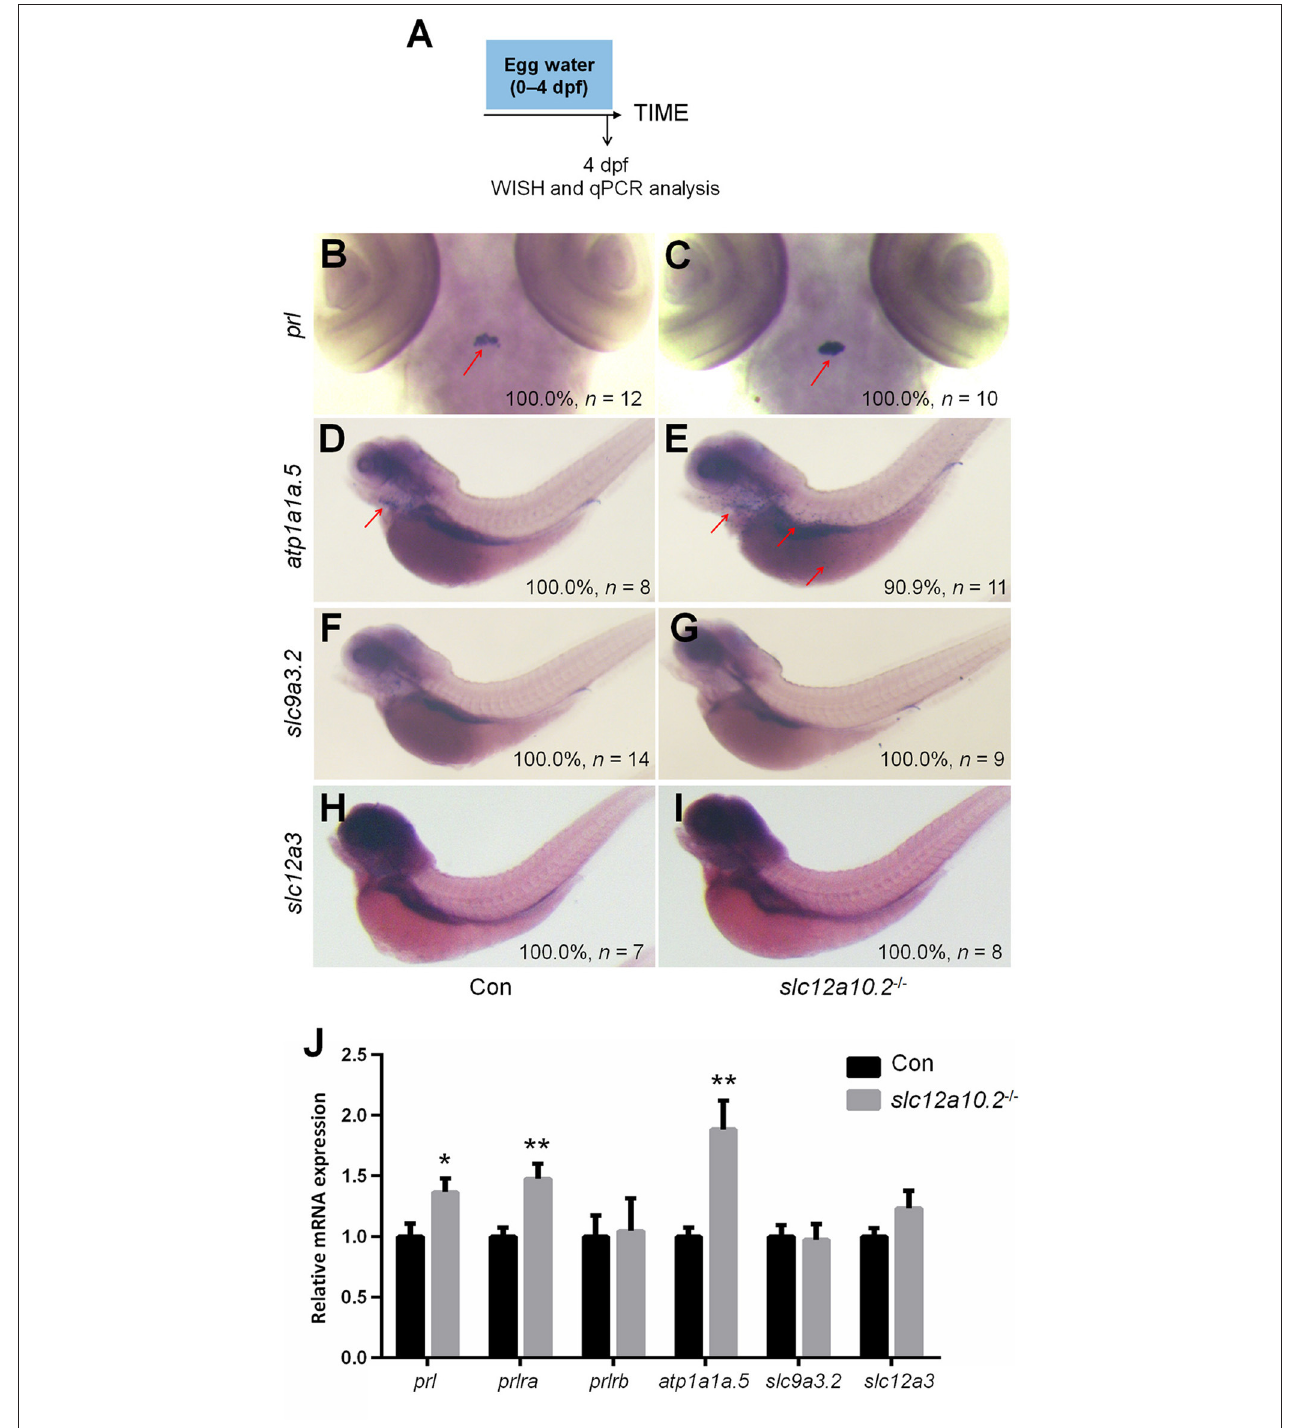
FIGURE 3 | Expressions of prl and PRL targets in control and slc12a10.2 -deficient larvae at 4 dpf. (A) Schematic diagram of the rearing timeline. Larvae were harvested at 4 dpf for WISH and qPCR analysis. (B,C) WISH analysis using the probe of prl in control and slc12a10.2 -deficient larvae at 4 dpf. (D,E) WISH analysis using the probe of atp1a1a.5 in control and slc12a10.2 -deficient larvae at 4 dpf. (F,G) WISH analysis using the probe of slc9a3.2 in control and slc12a10.2 -deficient larvae at 4 dpf. (H,I) WISH analysis using the probe of slc12a3 in control and slc12a10.2 -deficient larvae at 4 dpf. Red arrows indicate the expressions of the nominated genes. (J) Expression levels of prl , prlra , prlrb , atp1a1a.5 , slc9a3.2 , and slc12a3 in control larvae and slc12a10.2 -deficient larvae at 4 dpf were examined with qPCR. * P < 0.05. ** P < 0.01.